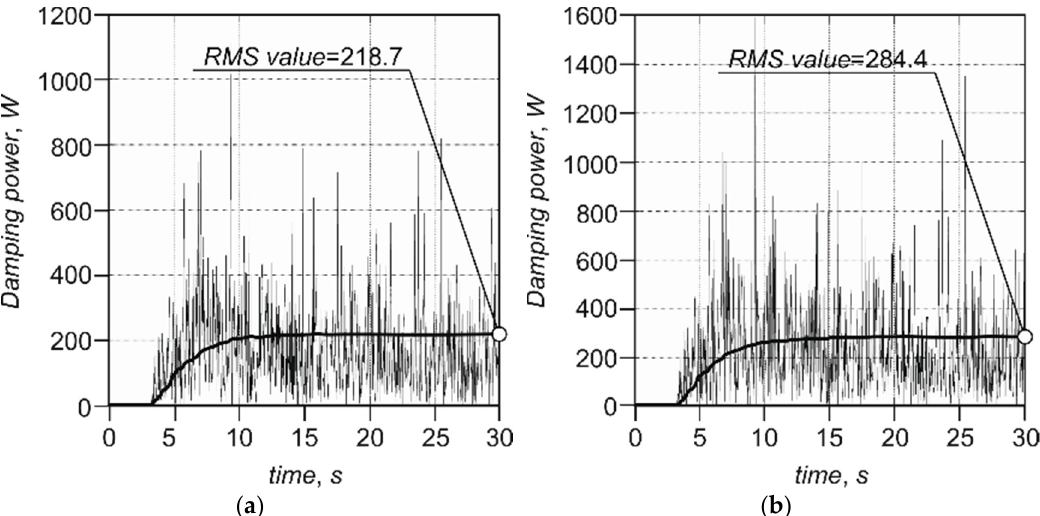
Figure 6. Damping power dependencies over time, obtained from the model for road no. 6: ( a ) Permanent damping with h SF 1 = 7500 Ns/m; ( b ) Optimized damping law. RMS—root mean square.